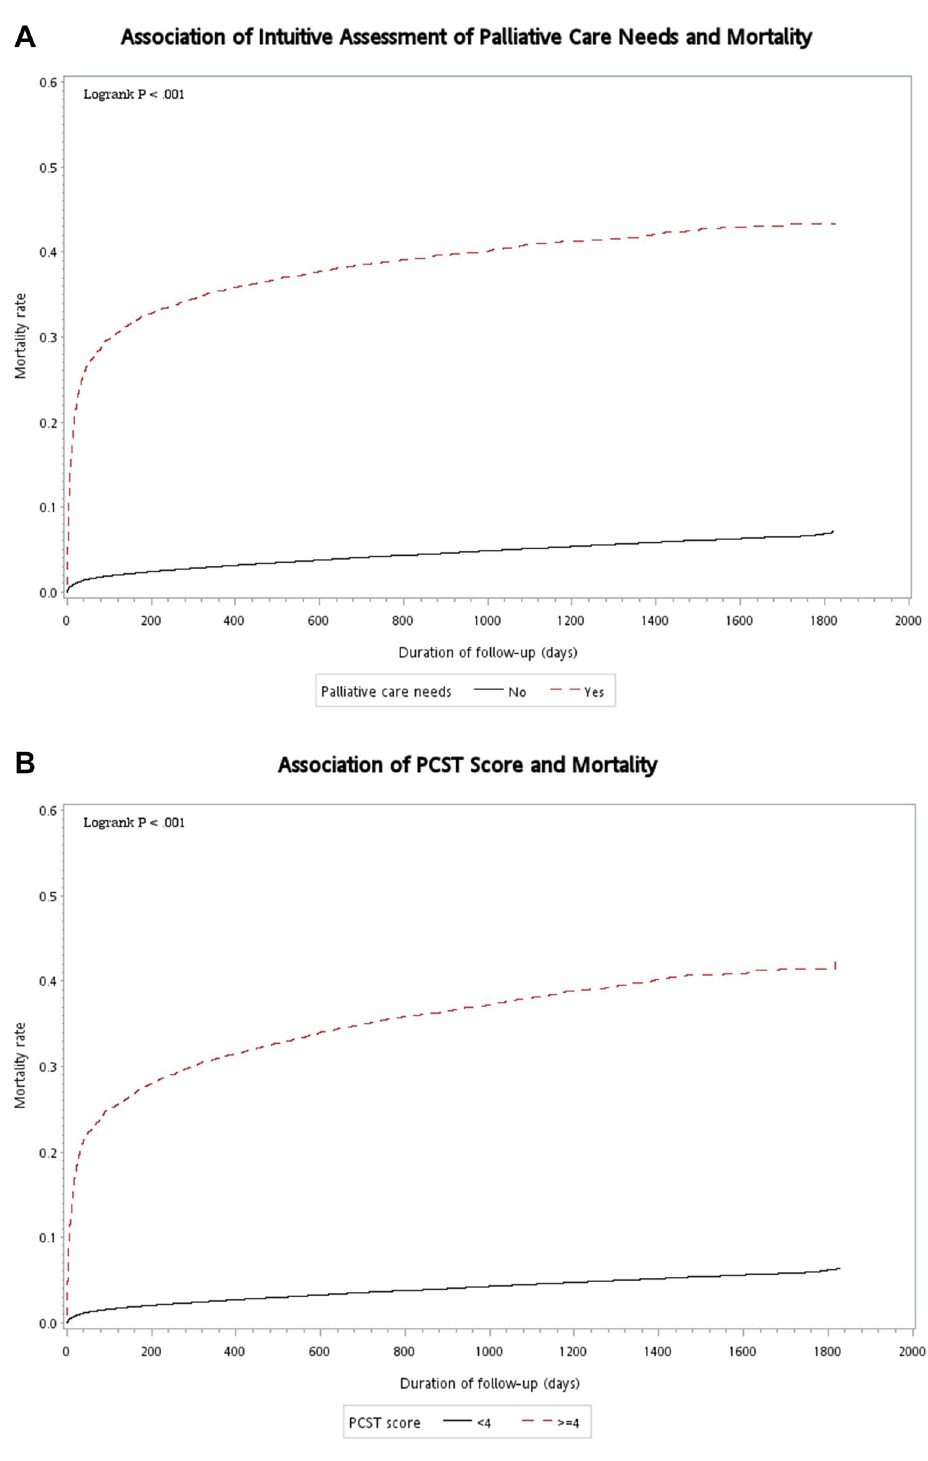
Figure 1. ( A ) Kaplan–Meier curves for time to death in patients with an intuitive assessment of palliative care needs ‘yes’ and ‘no’. ( B ) Kaplan–Meier curves for time to death in patients with PCST scores of ≥ 4 and < 4. Abbreviations: PCST: palliative care screening